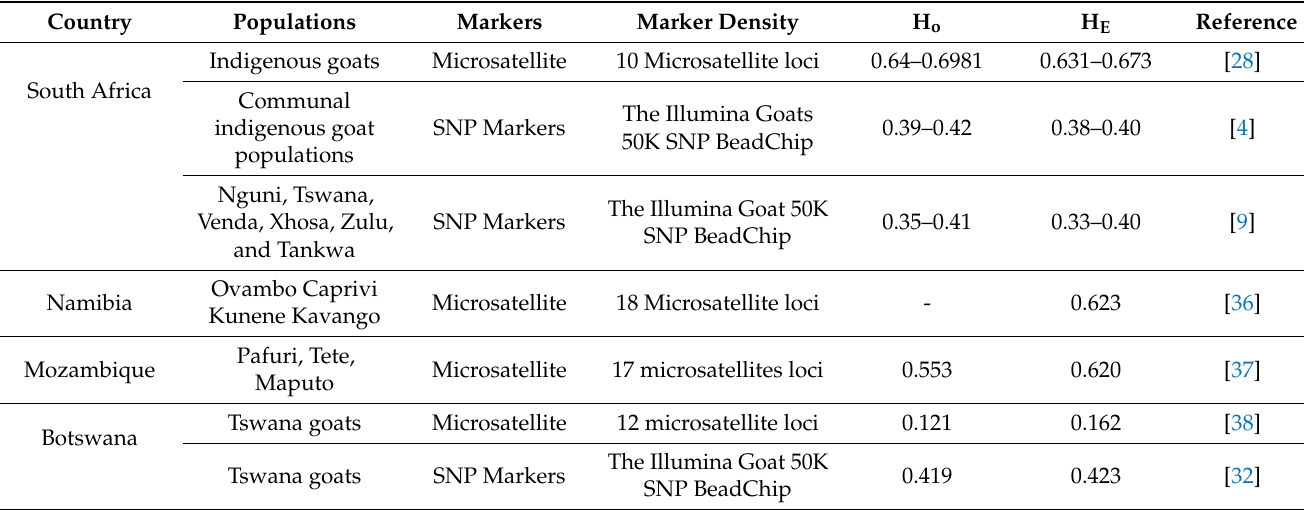
Table 3. Genetic diversity of Southern African indigenous goats using microsatellite and SNP